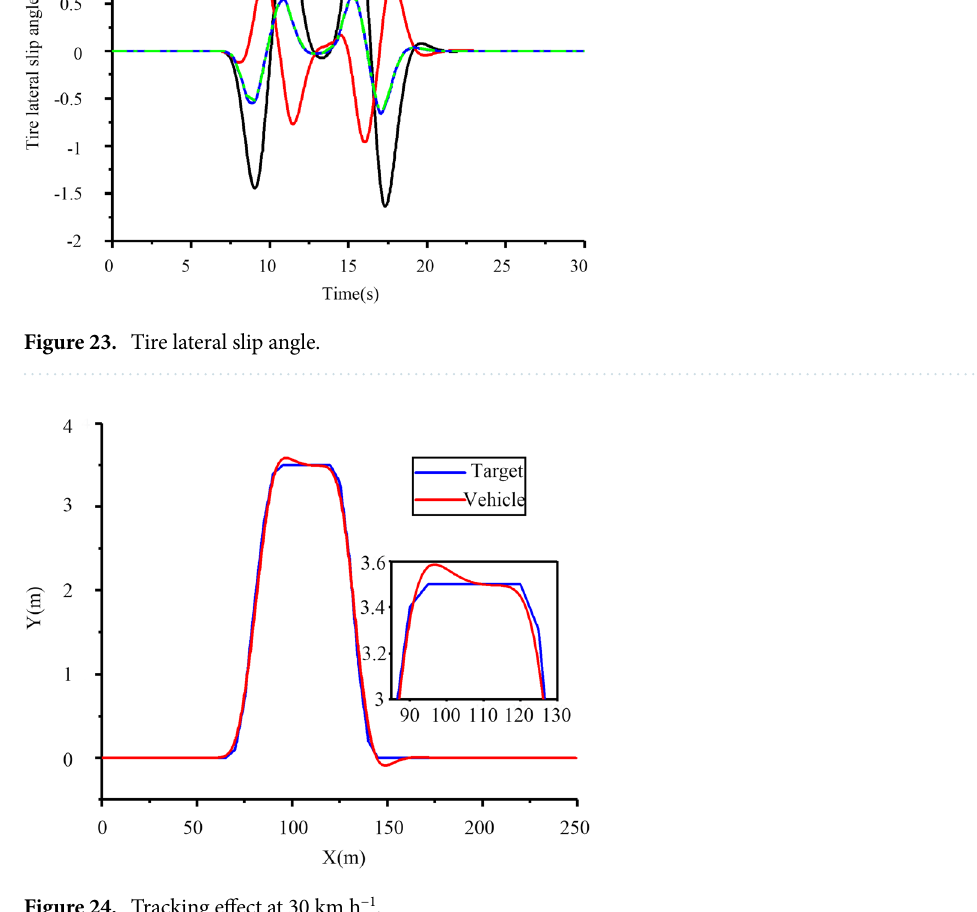
Figure 24. Tracking effect at 30 km h −1